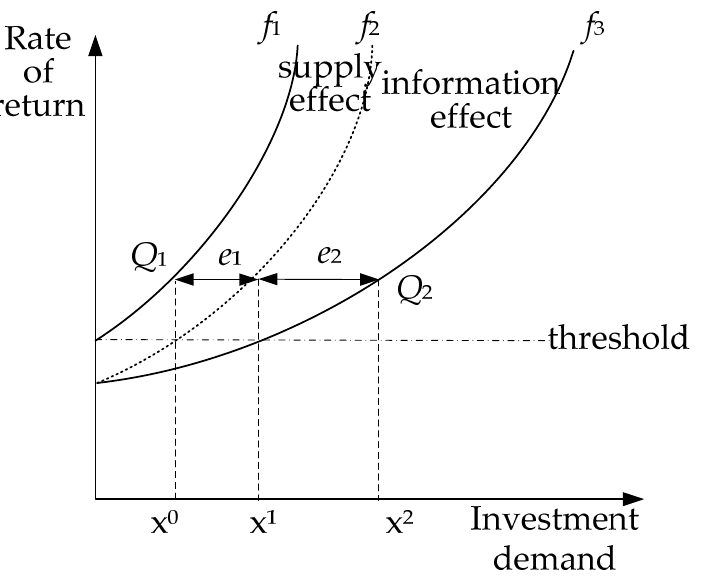
Figure 1. The mechanism of the impact of digital payment on the investments of farmer households.